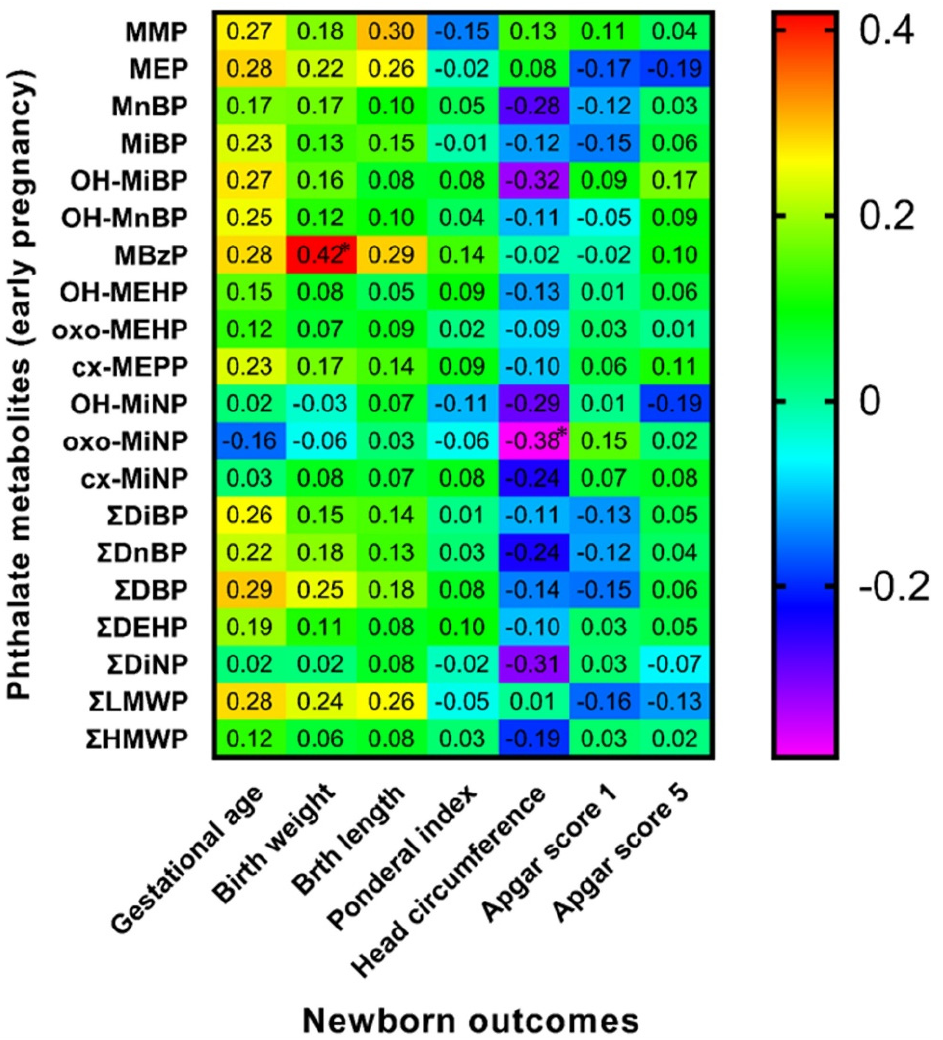
Figure 3. Correlation matrix of boy-newborn outcomes and maternal phthalate metabolites during early pregnancy ( ≤ 15. w.g.). Legend is shown in the footnote of Table 4. * The correlation is significant at the level p ≤ 0.05.